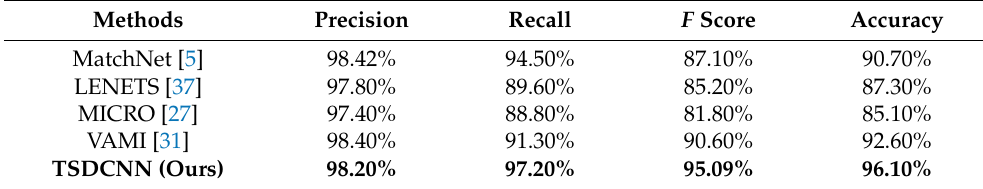
Table 4. Comparison with state-of-the-art methods for testing the subset of the VeRi776 dataset. Methods Precision Recall F Score Accuracy Appearance+Color+Model [19] 87.70% 61.11% 89.27% Combining Network [27]